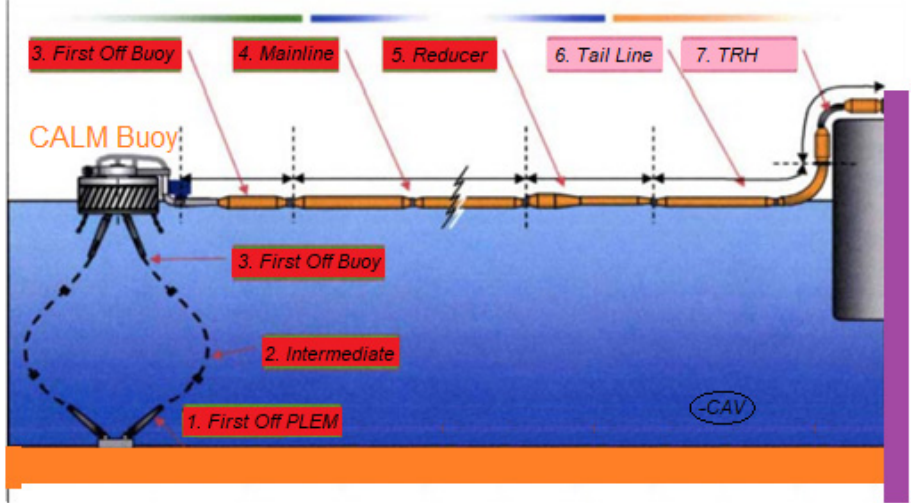
Figure 22. Hose array on a CALM buoy hose system, showing 7 different types of hoses utilized on a classical SPM terminal, namely: ( 1 ) first off PLEM, ( 2 ) intermediate, ( 3 ) First off Buoy, ( 4 ) Mainline, ( 5 ) Reducer, ( 6 ) Tail line, and ( 7 ) Tanker Reeling Hose (TRH).